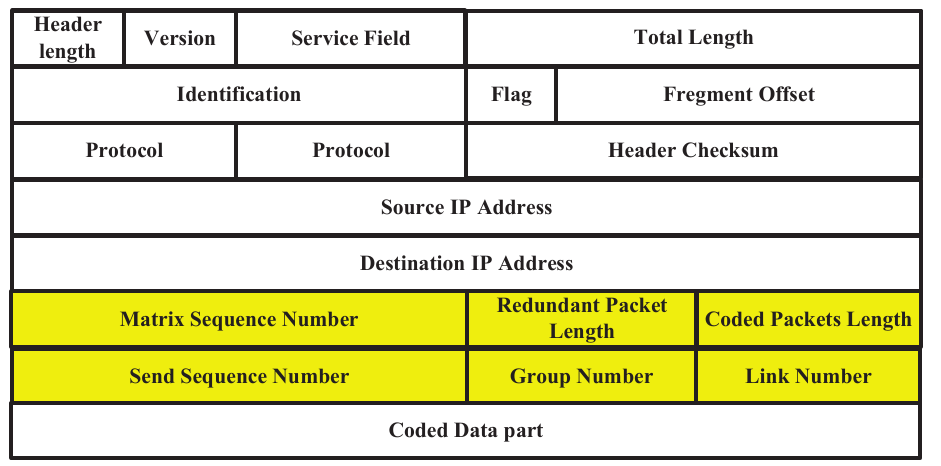
Figure 4. Customized header format in IP